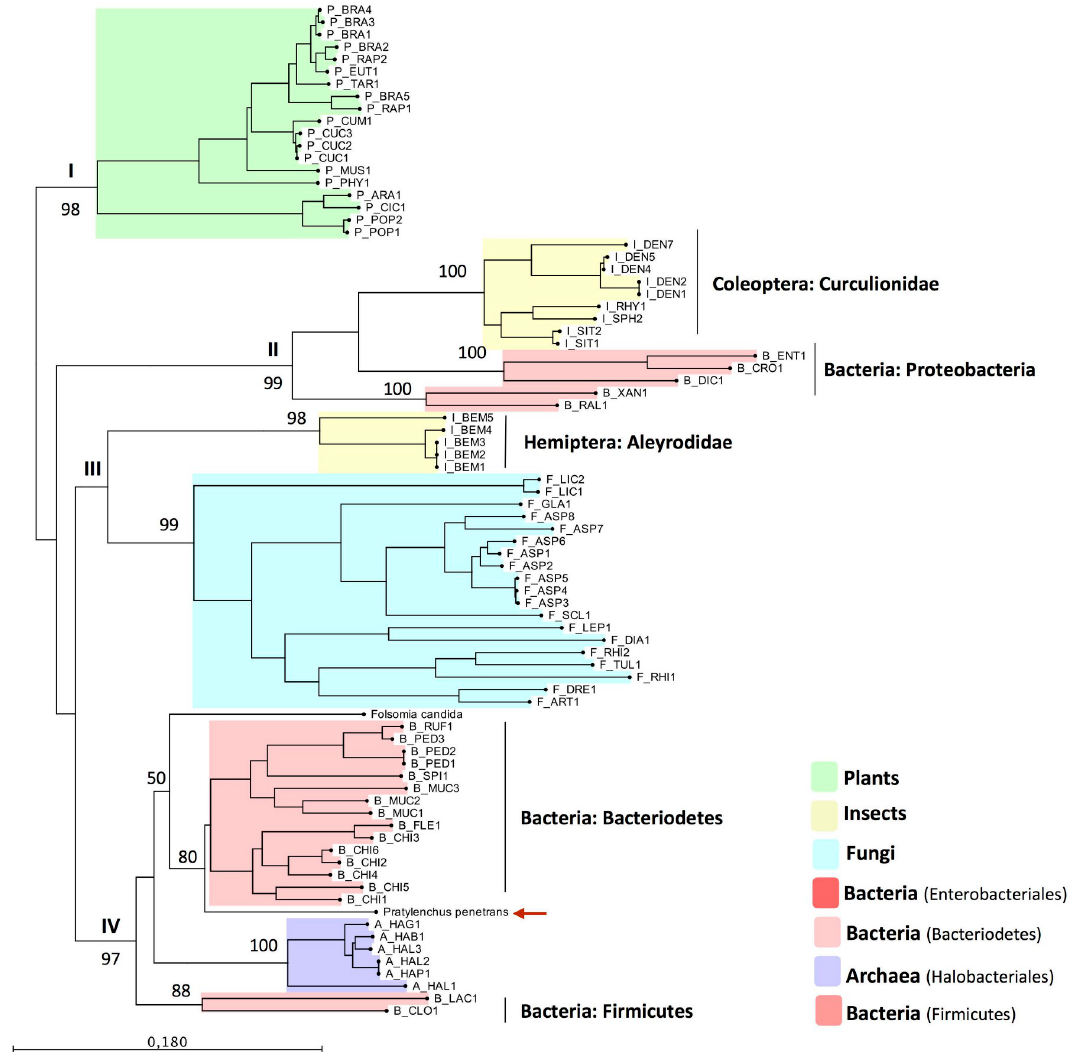
Fig 4. Phylogenetic tree based on the closest homology to the catalytic domain of Pp-PME. The PME sequences across different taxa were chosen based on the top BLAST hits against the Pp-PME predicted pectinesterase domain. The corresponding species names and range of e-values are presented in S3 Table. The red arrow indicates the position of P . penetrans PME. The phylogenetic tree was deduced by Maximum Likelihood with the “Whelan and Goldman” (WAG) model with discrete gamma distribution and 1000 bootstrap